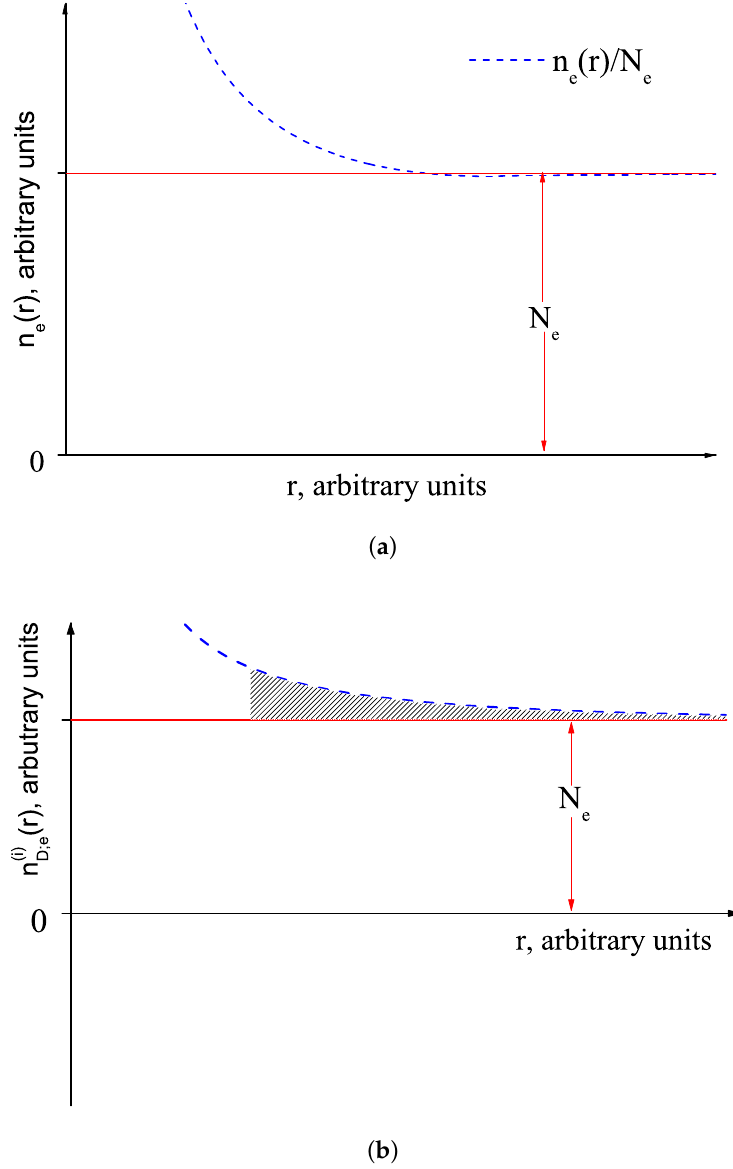
Figure 1. ( a ) The behavior of the electron density in the case of the electron–ion plasma with the probe particle whose charge is equal to that of the ions; ( b ) the behavior of the Debye-Hückel (DH) electron in the case of the electron-proton plasma with the probe particle whose charge is equal to that of the